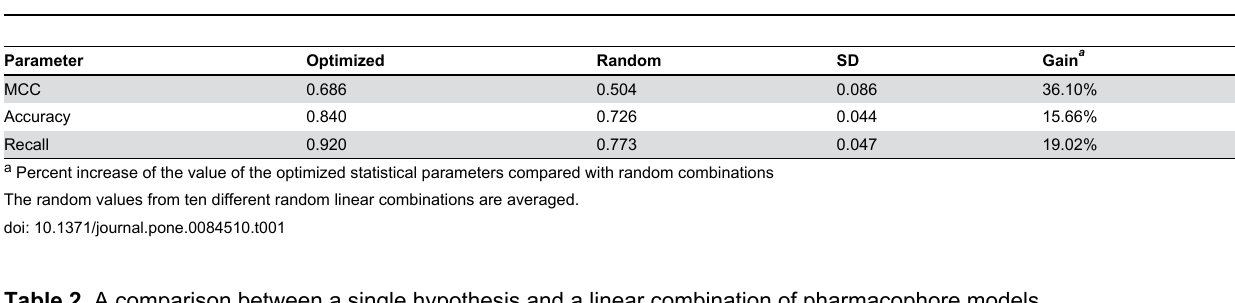
Table 1. A comparison between the optimized parameter values and those obtained for randomly selected combinations consisting of the same number of single hypotheses as optimized combinations.